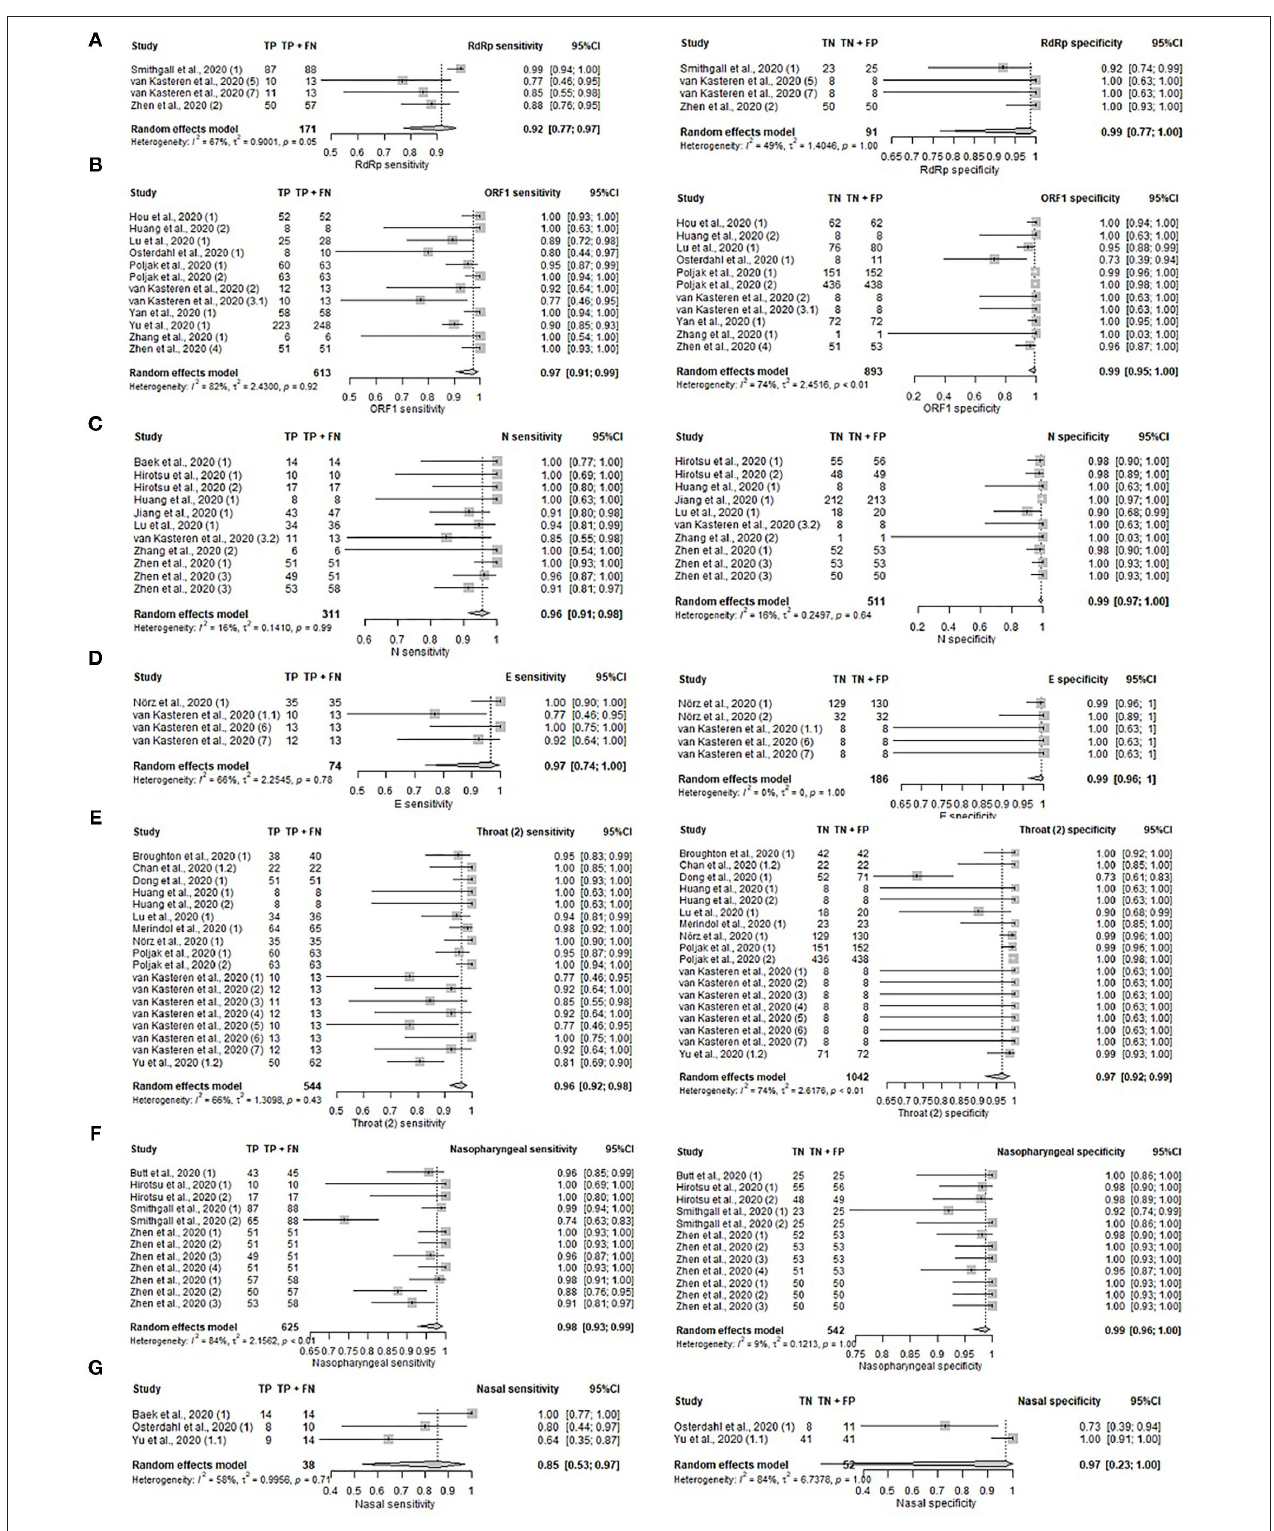
FIGURE 5 | Forest plot on gene targets and specimen sites. (A–D) Pooled sensitivity and specificity on gene target. (A) RdRp gene, (B) ORF1 gene, (C) N gene, (D) E gene. (E–G) Pooled sensitivity and specificity on specimen sites. (E) Unspecified throat, (F) nasopharyngeal, and (G) nasal.